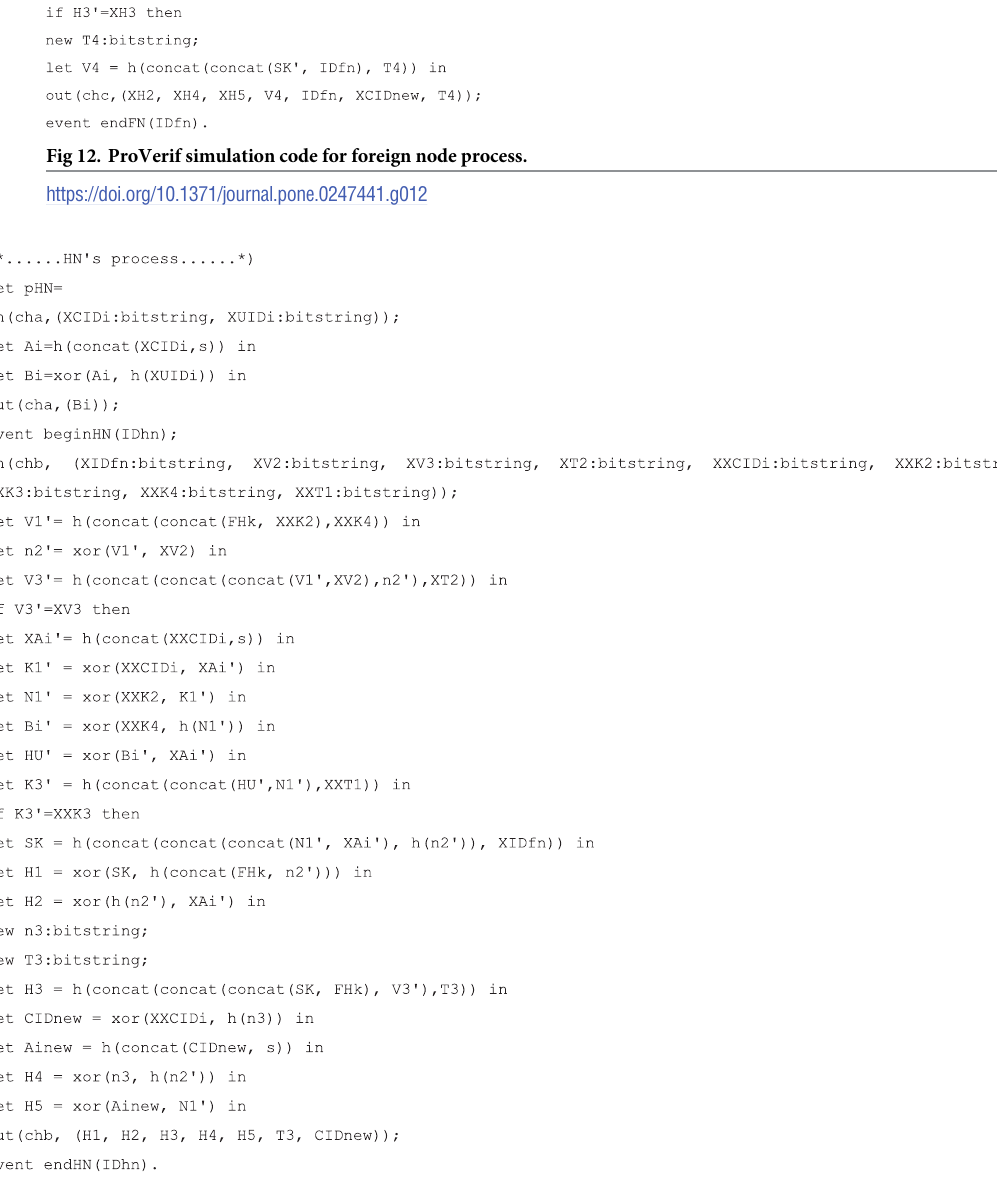
Fig 13. ProVerif simulation code for the home node